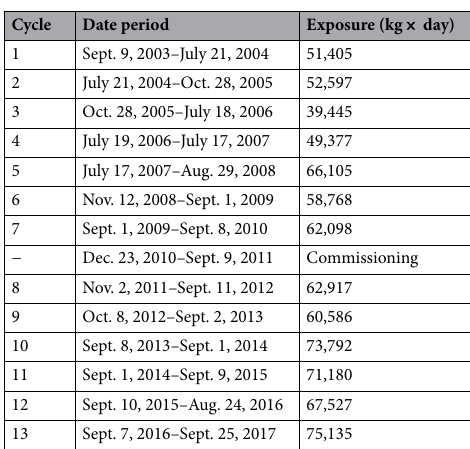
Table 1. DAMA/LIBRA annual cycles Thirteen annual cycles used by DAMA/LIBRA are obtained from Refs. 15,16,26 .